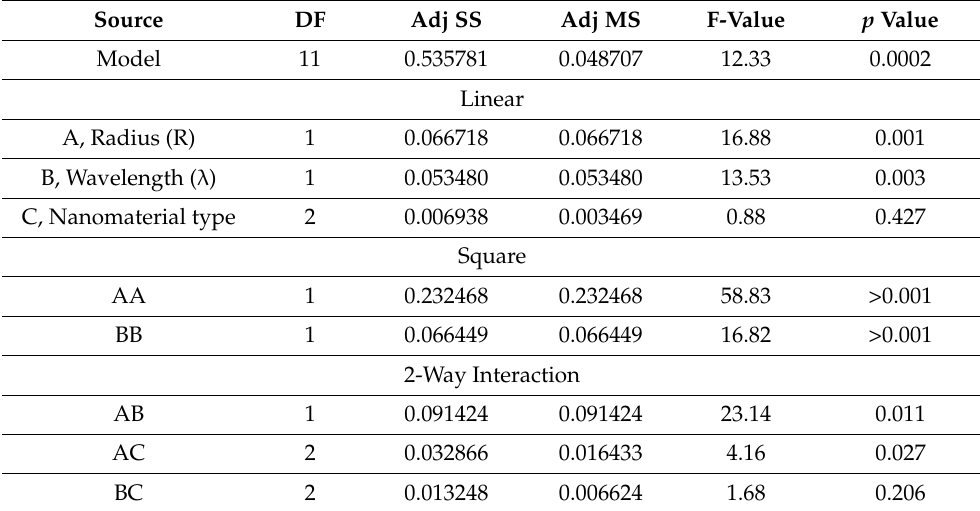
Table 2. Analysis of variance of silicon solar cell (reflectance